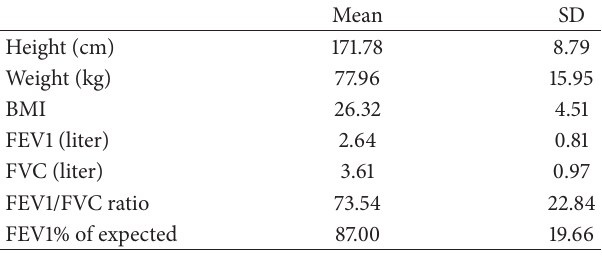
Table 2: Medical Research Council (MRC) average score in esti- mated severity in groups of COPD ∗ ( 𝑁 = 1